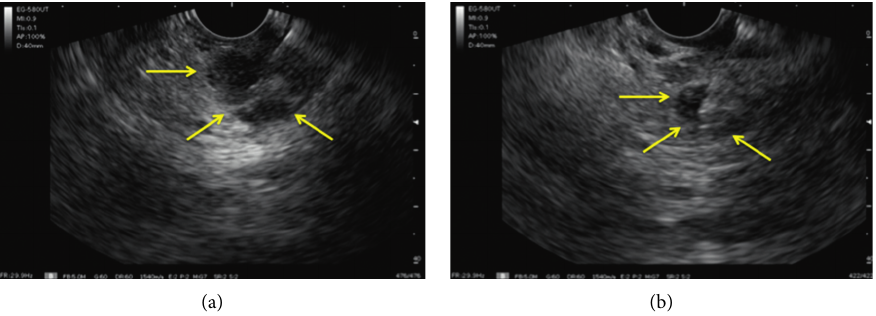
Figure 3: (a) and (b) EUS-FNA with Procore 20G needle.